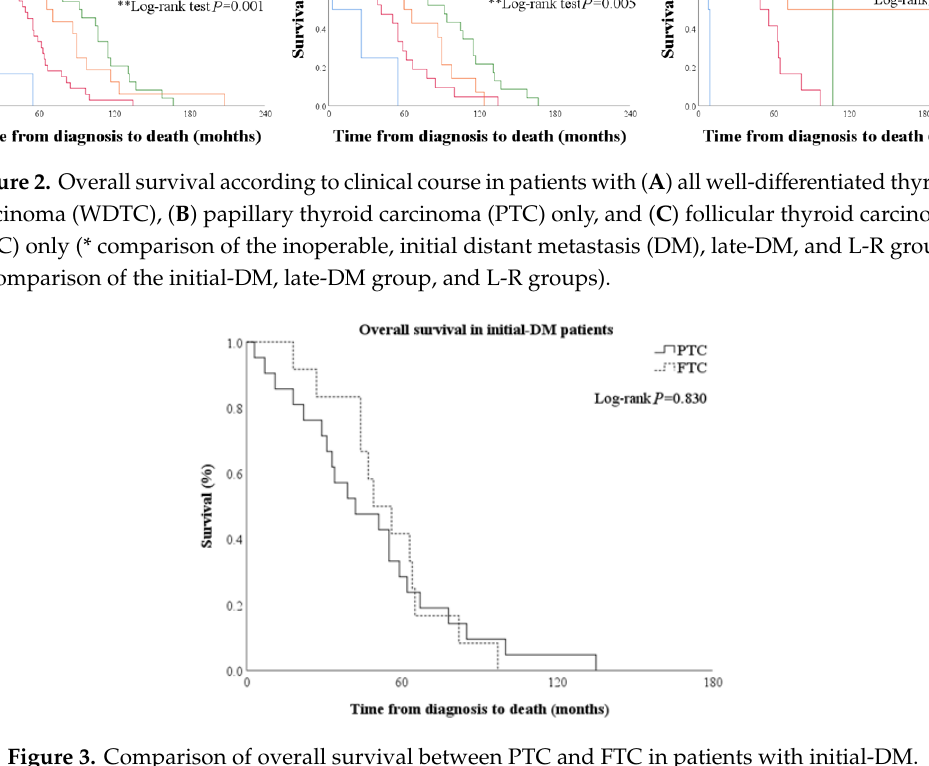
Figure 3. Comparison of overall survival between PTC and FTC in patients with initial-DM.